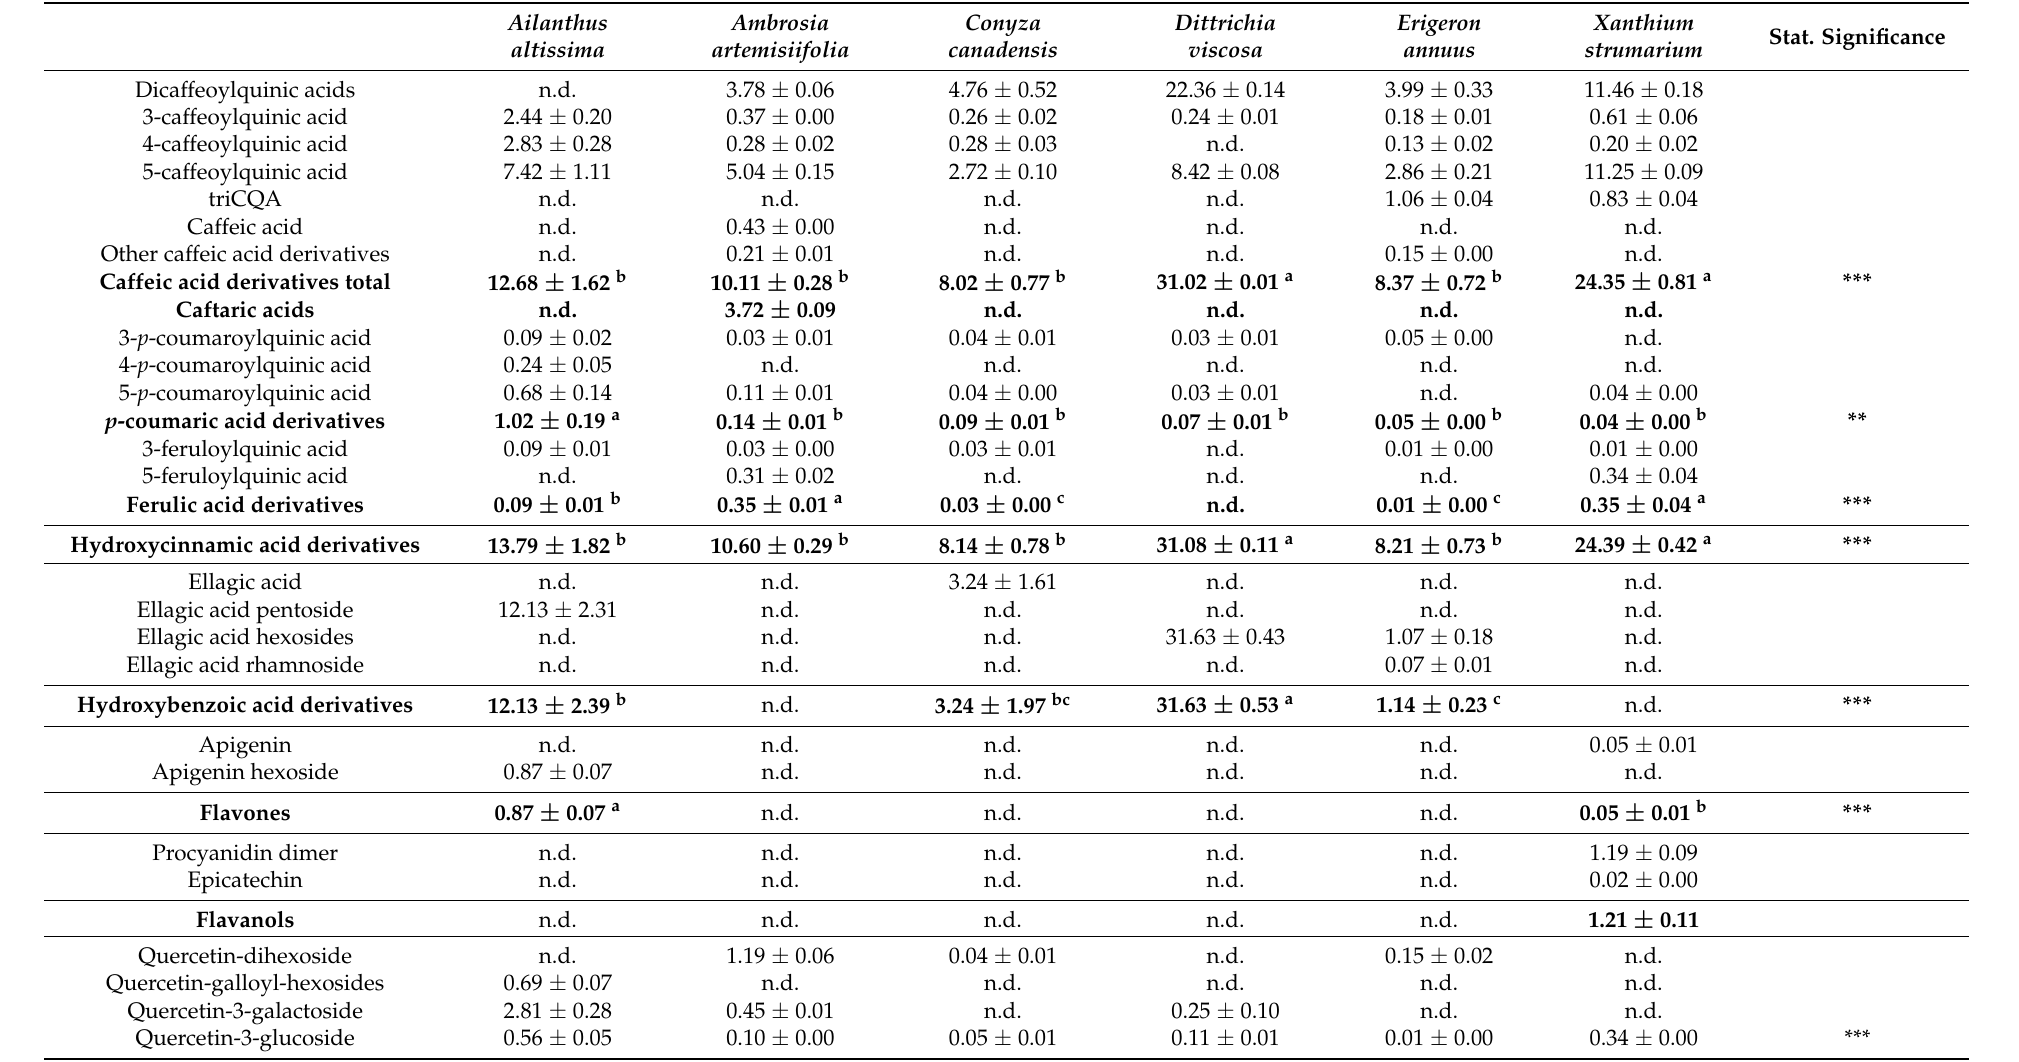
Table 1. The concentrations of identified phenolics in six invasive plant species (mg/g DW ± standard error). Data are presented as a heat map in Supplementary Figure